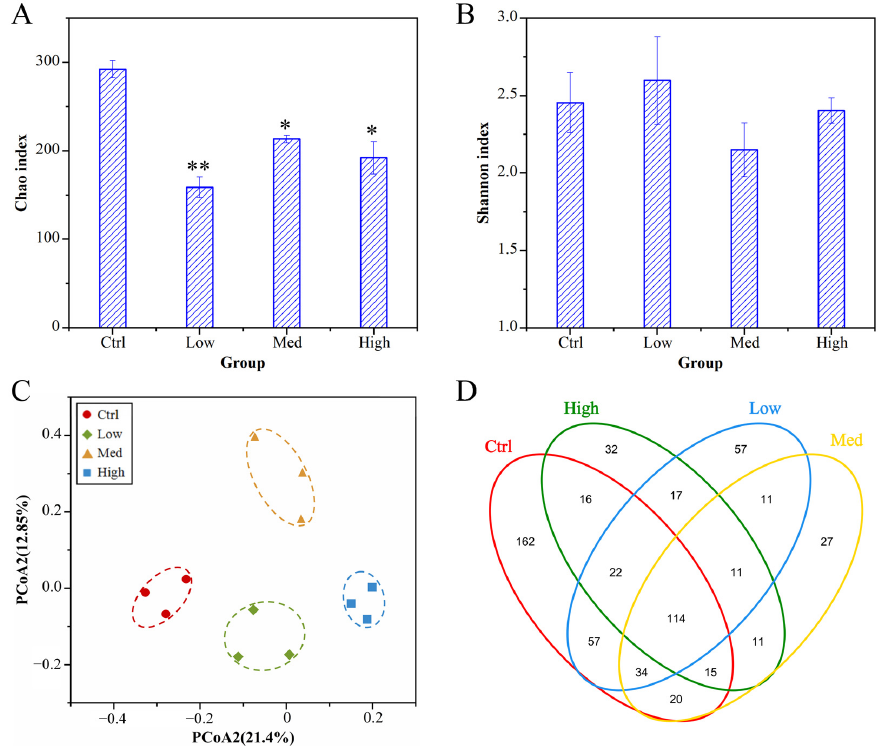
Figure 8. Alpha- and Beta-diversities of intestinal microbiome of P. clarkii in the Hg-treated groups: ( A ) Chao indices of bacterial community. ( B ) Shannon indices of bacterial community. ( C ) PCoA of the microbiome. ( D ) Venn diagram showing the number of shared and unshared OTUs among the different Hg-treated groups. * p ≤ 0.05, ** p ≤ 0.01. Data are shown as mean ± SD. Ctrl: 0 μ g/L Hg 2+ ; Low: 8.75 μ g/L Hg 2+ ; Med: 21.875 μ g/L Hg 2+ ; High: 43.75 μ g/L Hg 2+ .